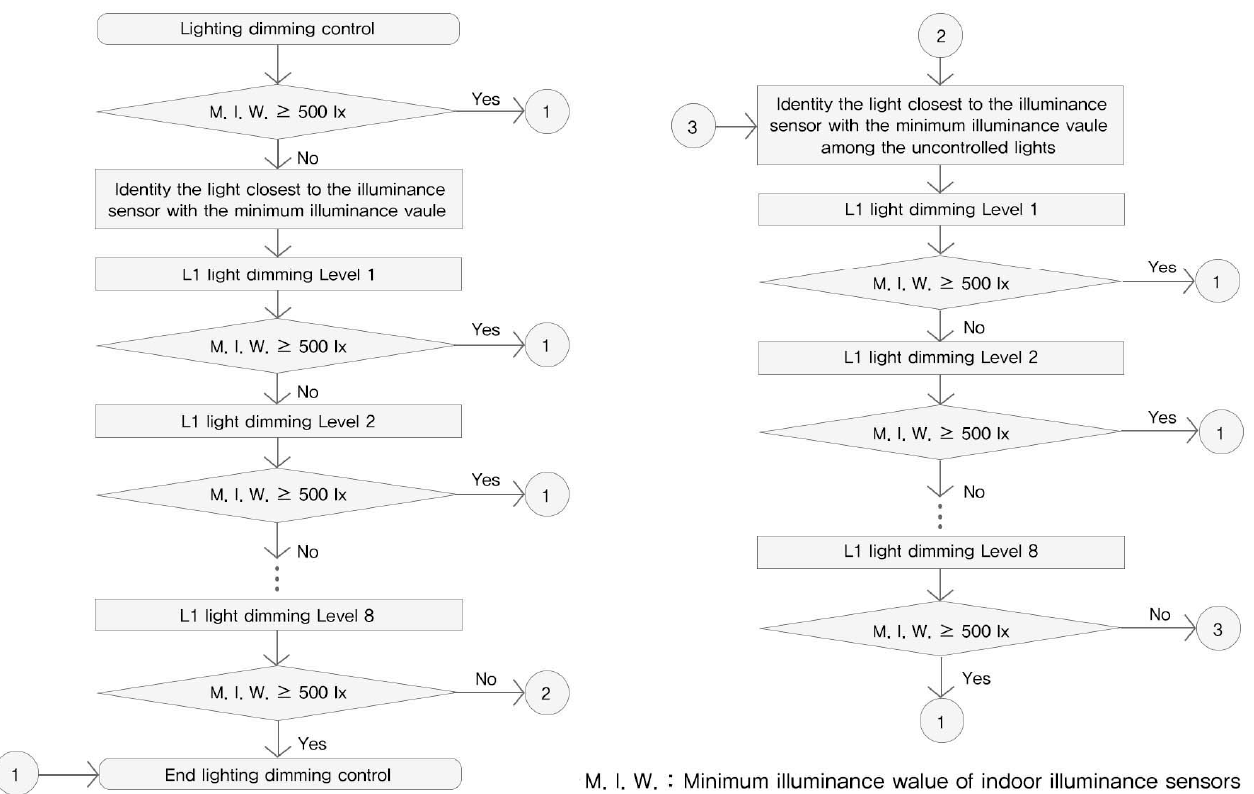
Figure 7. Lighting dimming control flow chart for performance evaluation.